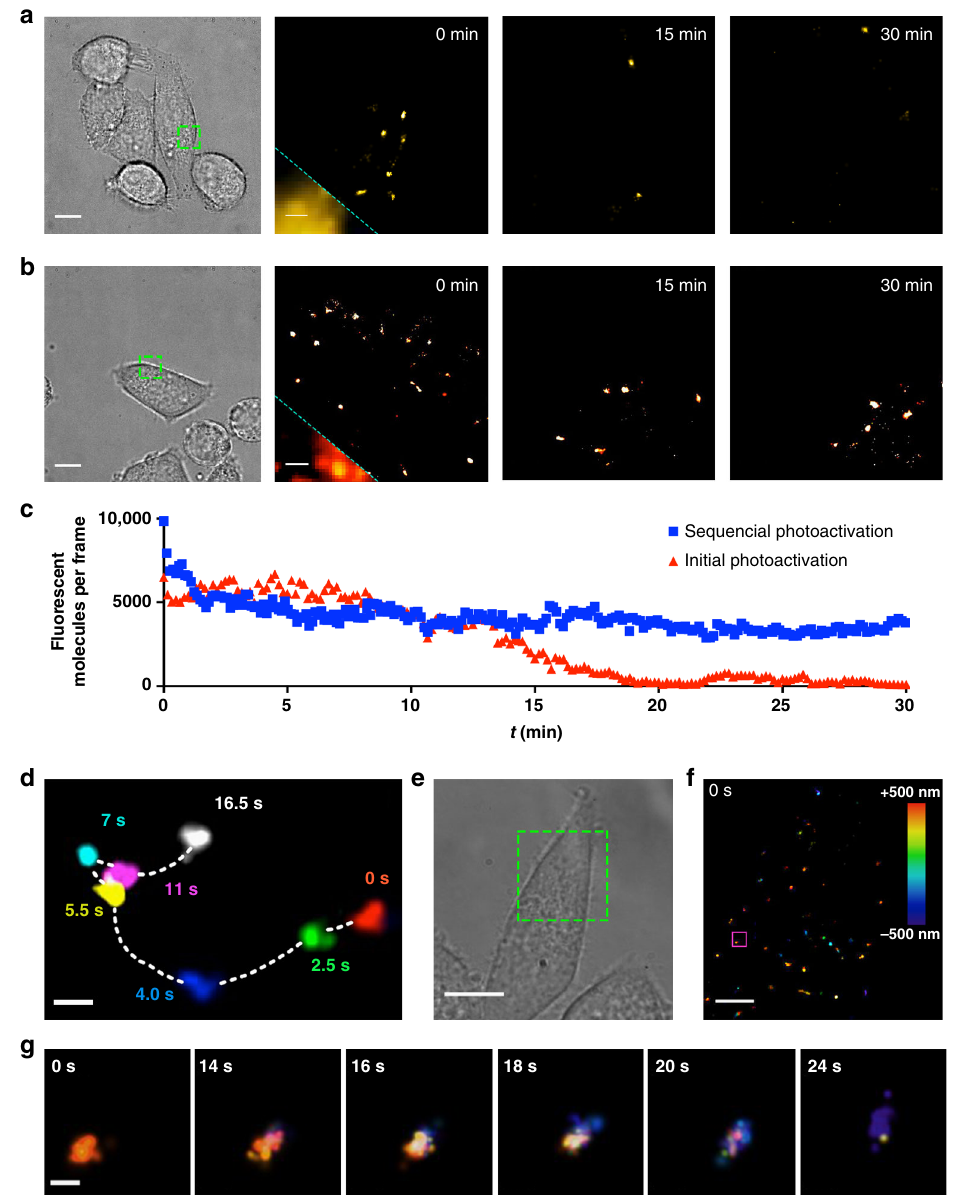
Fig. 4 Time-lapse, 2D and 3D SMLM of lysosomes in live HeLa cells using PFF- 1 . a Time-lapse SMLM of lysosomes in a live HeLa cell applying a single photoactivation pulse (405 nm, 2.6 W cm − 2 , 20 ms). The green, dotted square in the bright- fi eld image indicates the area imaged during the SMLM experiment. The bottom left corner of the image at 0 s displays the diffraction-limited image for comparison. b Time-lapse SMLM of lysosomes in a live HeLa cell applying photoactivation pulses (405 nm, 2.6 W cm − 2 , 20 ms) every 10 min. The green, dotted square in the bright- fi eld image indicates the area imaged during the SMLM experiment. The bottom left corner of the image at 0 s displays the diffraction-limited image for comparison. c Number of emissive molecules per frame over the entire acquisition employing probe PFF- 1 (500 nM) with an initial, single-photoactivation pulse (405 nm, 2.6 W cm − 2 , 20 ms, red triangles) or with the same pulse applied every 10 min (blue squares). d Single lysosome moving laterally within the focal plane in a live HeLa cell. e Bright- fi eld image of a live HeLa cell. The green, dotted square indicates the area displayed in panel ( f ). f Snapshot at 0 s of a 3D, time-lapse, SMLM experiment, color-coded according to depth in a 1 μ m-thick imaging volume. The magenta, solid-line square indicates the area displayed in panel ( g ). g Snapshots at different time points of a single lysosome diffusing in the axial direction, color-coded according to the scale depicted in panel ( f ). Scale bars from panels ( a , b ) 10 μ m (bright- fi eld) and 1 μ m (diffraction-limited and SMLM), respectively; ( d ) 500 nm; ( e ) 10 μ m; ( f ) 5 μ m; ( g ) 200